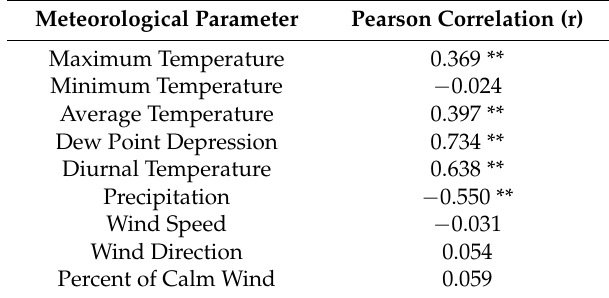
Table 1. The Pearson correlation coefficient results between the 12-month difference of the logarithm of water consumption and meteorological parameters input series in Las Vegas during 1990–2009 a .